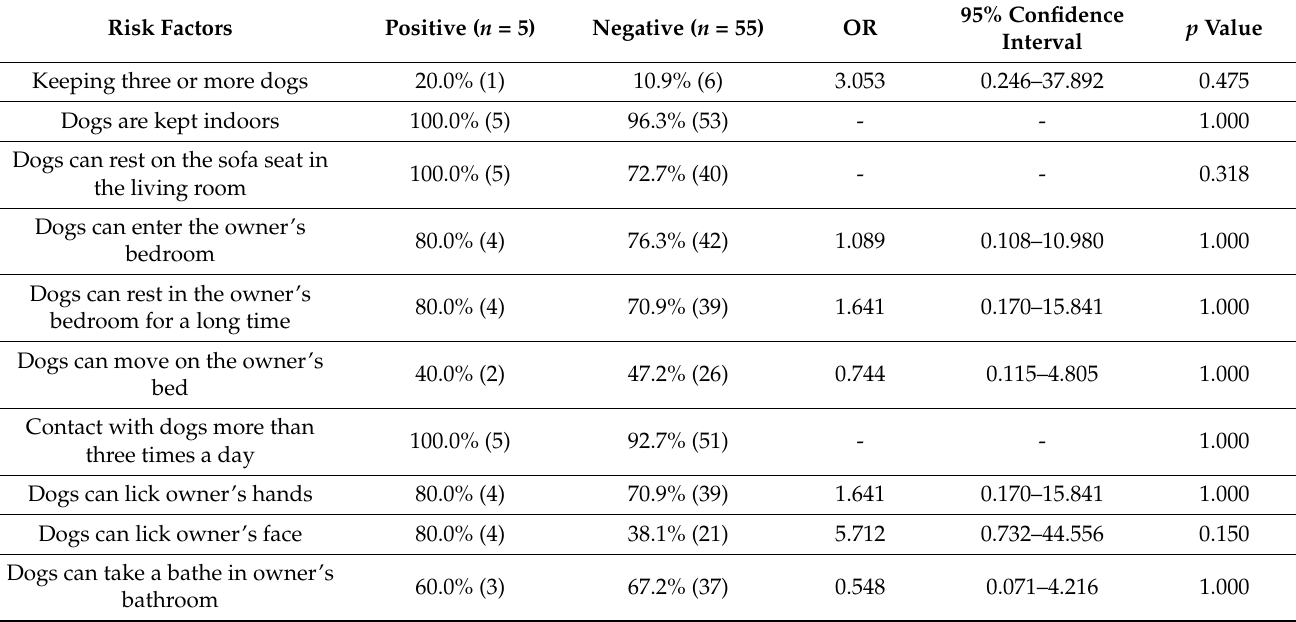
Table 7. Possible risk factors analysis for S. pseudintermedius isolated from